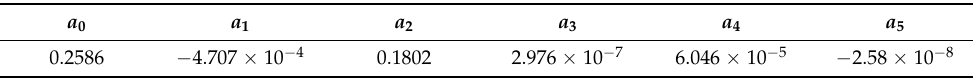
Table 6. Values of the fitting Equation